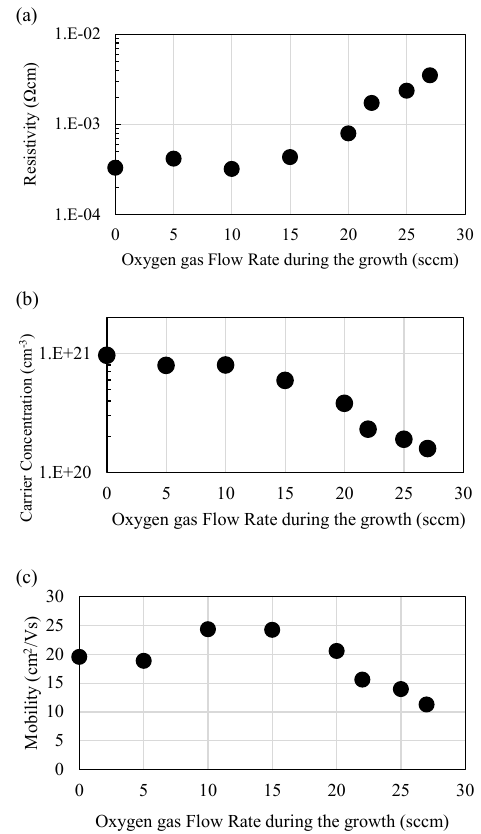
Figure 3. Resistivity as a function of oxygen gas flow rate for GZO films (a) . Carrier concentration as a function of oxygen flow rate for GZO films (b) . Hall mobility as a function of oxygen flow rate for GZO films (c) Figure 3. (a) Resistivity as a function of oxygen gas flow rate for GZO films. (b) Carrier 7 concentration as a function of oxygen flow rate fo GZO films. (c) Hall mobility as a function 8 of oxygen flow rate for GZO films. 9